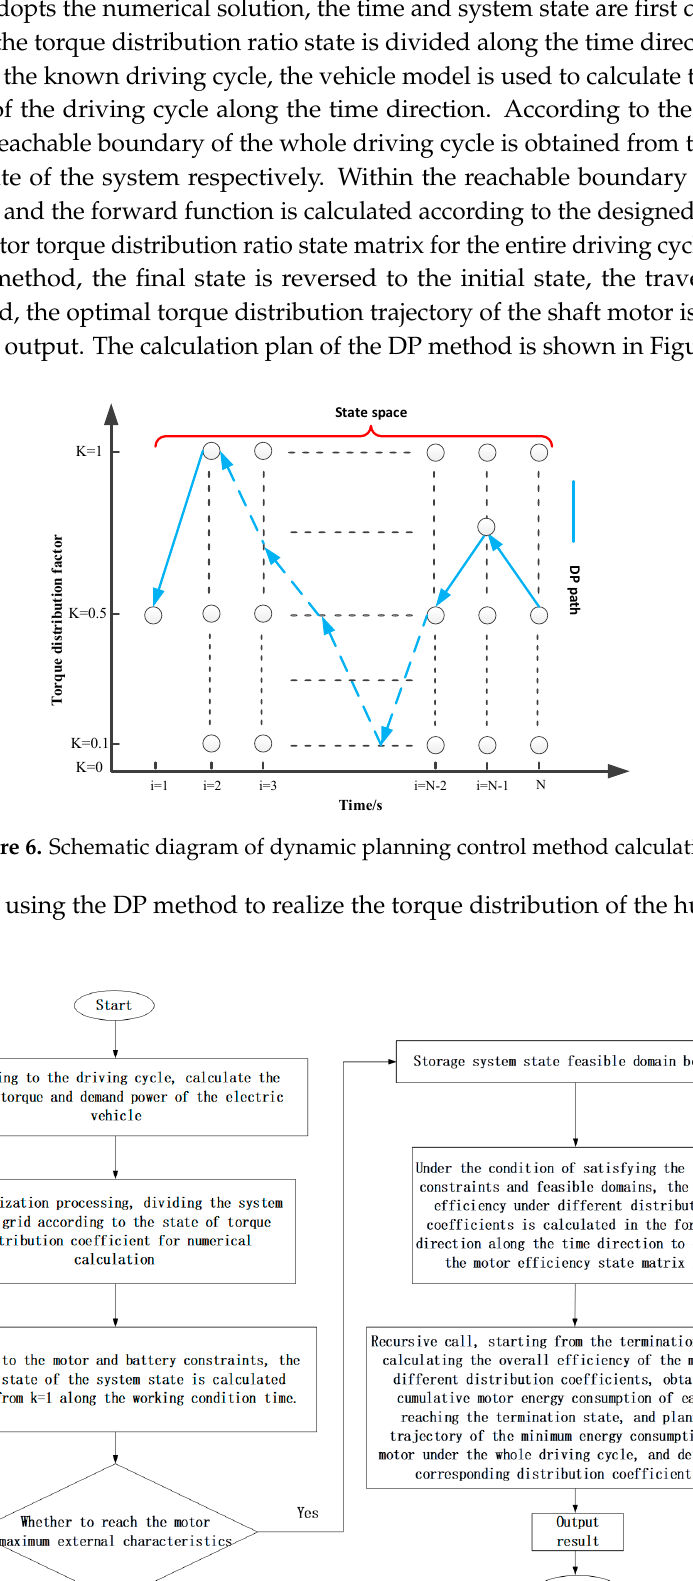
Table 2. Basic parameters of the simulation sample car.